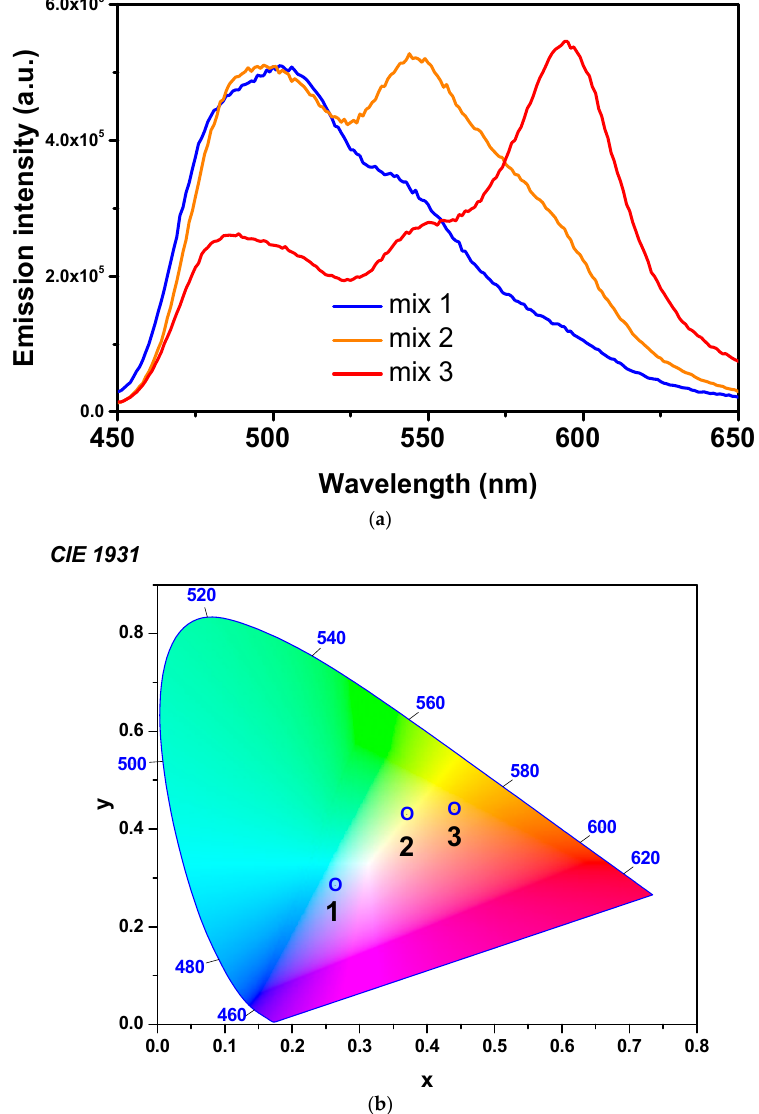
Figure 8. ( a ) Photoluminescence (PL) spectra of submicronic fibers produced by electrospinning from different mixtures of dye-doped polymer solutions, and ( b ) their corresponding coordinates on Commission Internationale de L’Eclairage (CIE) 1931 color space chromaticity diagram.